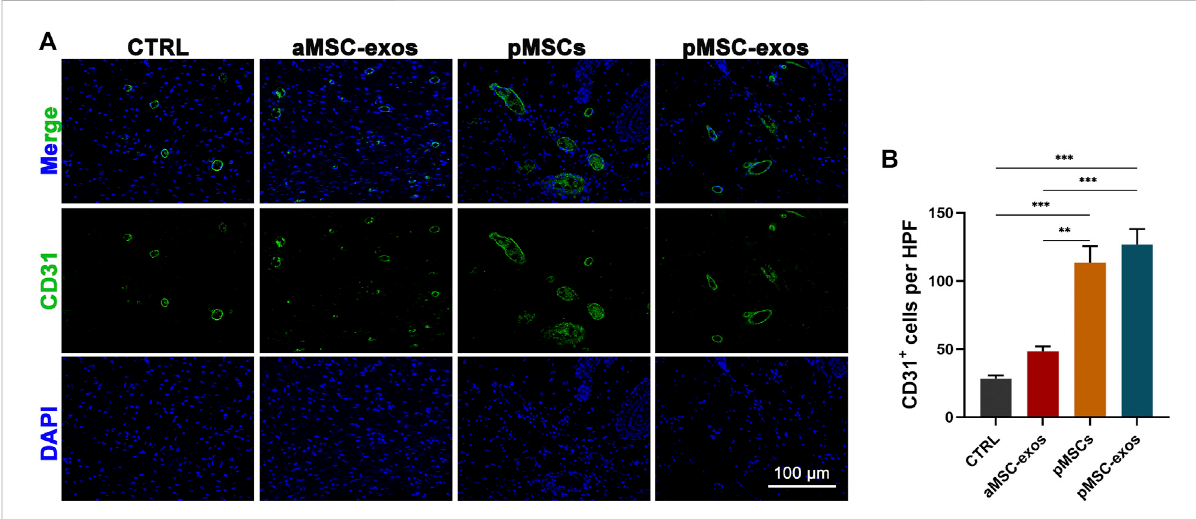
FIGURE 5 pMSC-exos improveregeneration ofbloodvessels inwoundhealing. (A) CD31 IFstainingofthehealedskin. (B) NumberofCD31 + cellsper HPF according to IF staining. Mean ± SEM; ** p < .01, *** p < .001; n =